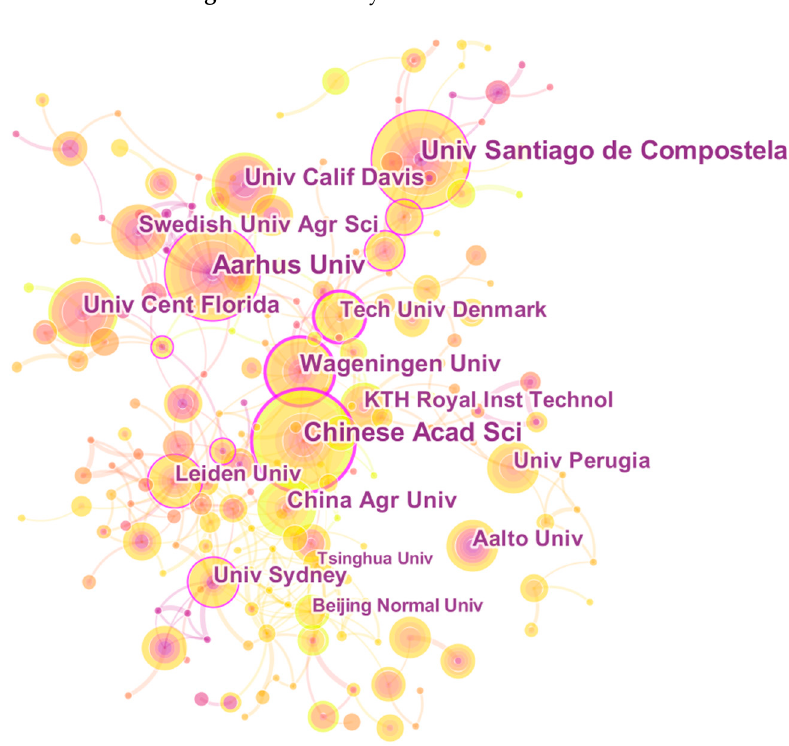
Processes 2019 , 7 , x FOR PEER REVIEW Figure A3. Country collaboration network. Figure A3. Country collaboration network.